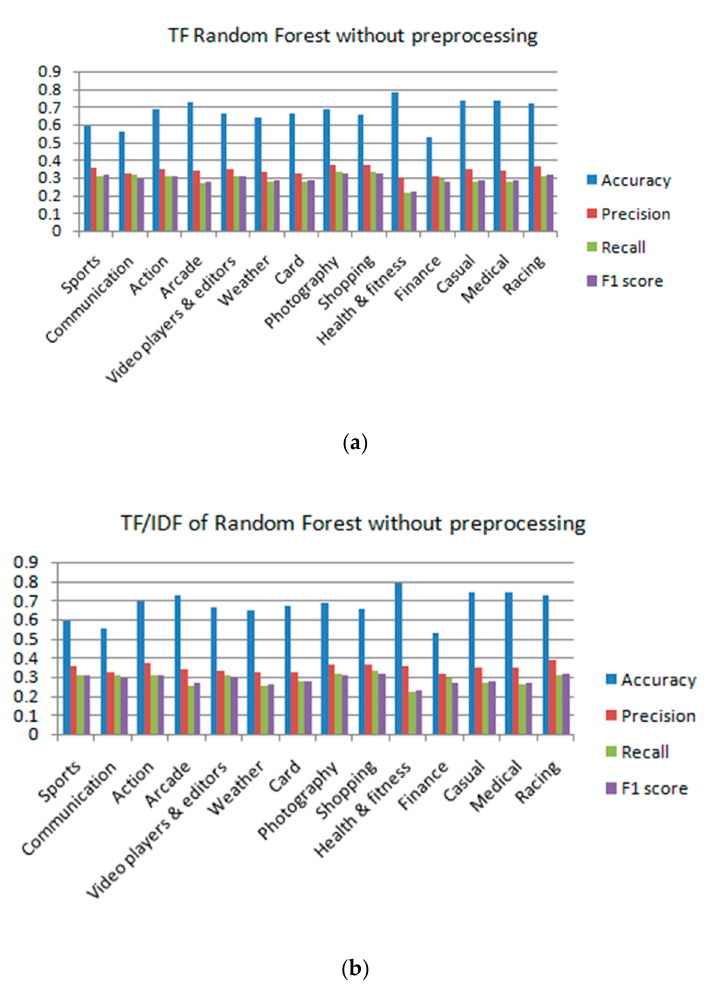
Figure 9. ( a ) Bar-chart visualization of TF random forest algorithm based without preprocessing of data; ( b ) bar-chart visualization of TF random forest algorithm based without preprocessing of data.